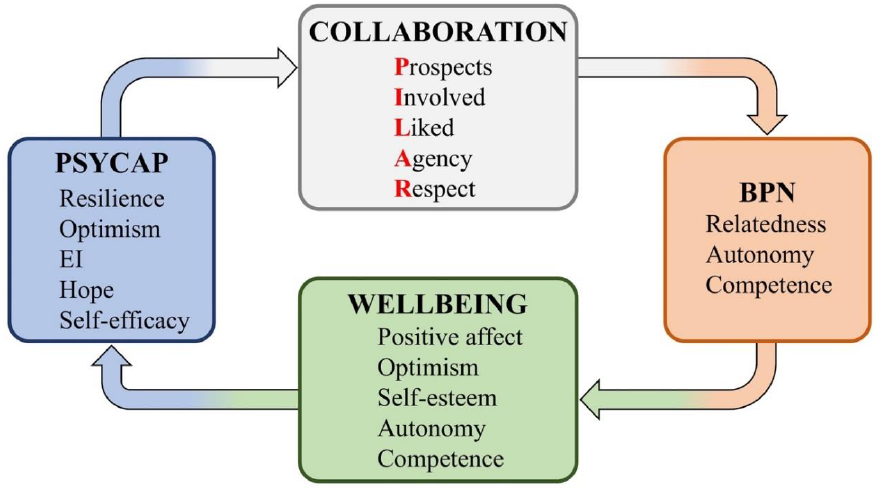
Figure 1. Cyclical interaction of collaboration, positive psychology, and wellbeing.